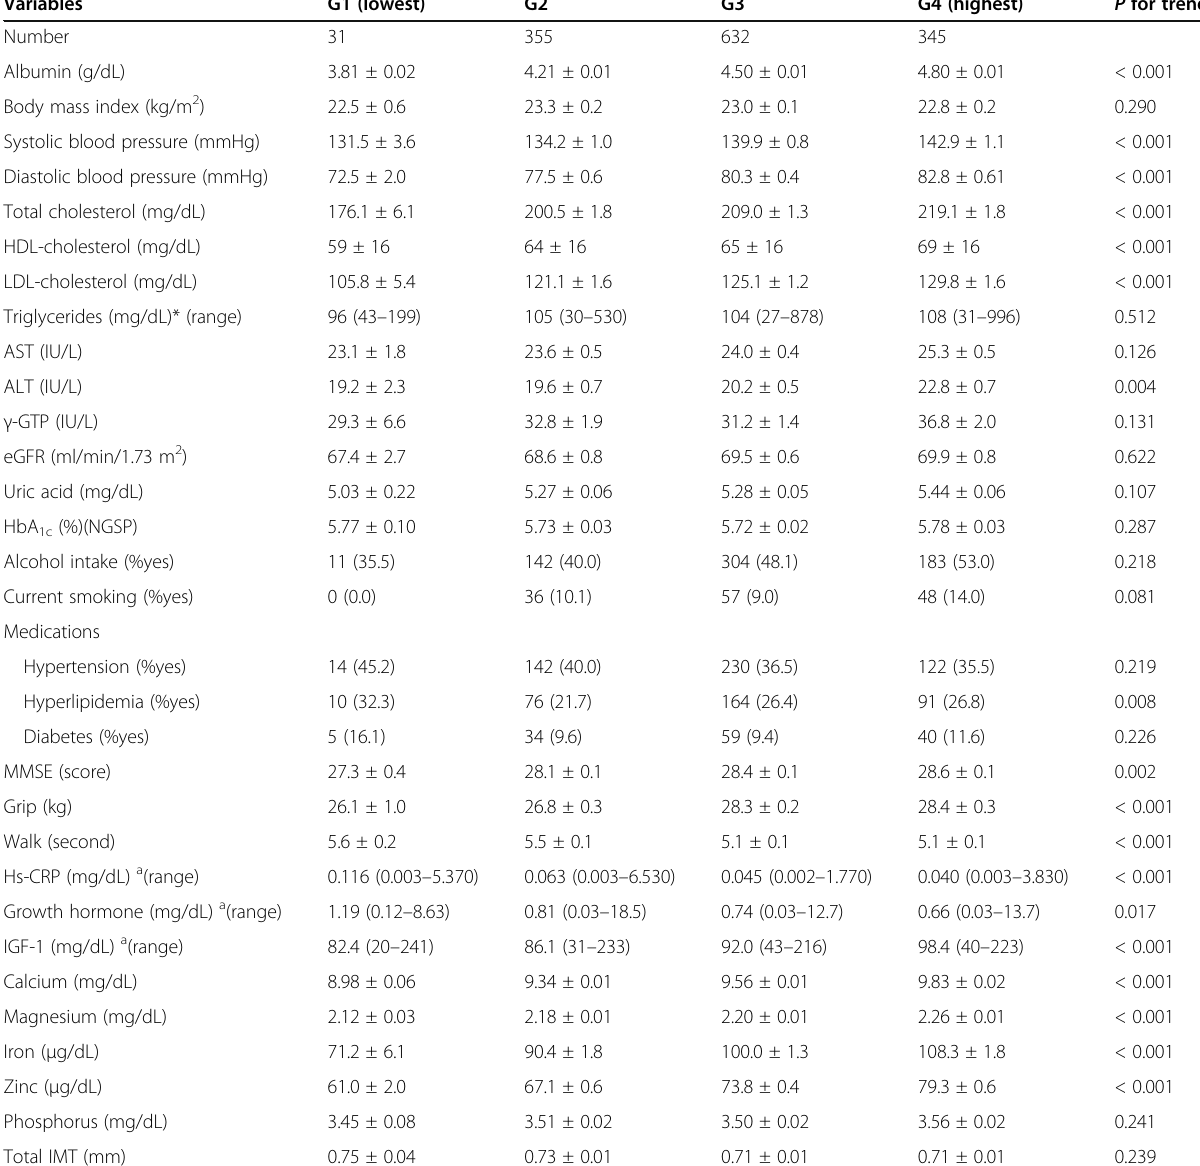
Table 2 Age and sex-adjusted means of parameters stratified by serum albumin groups